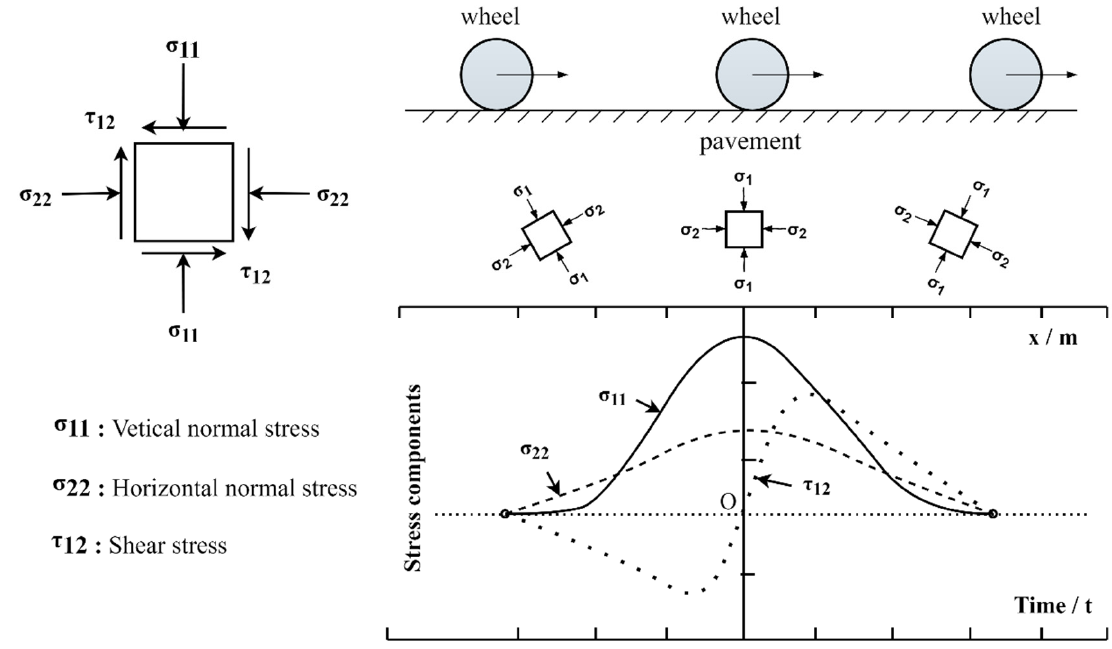
Figure 1. Stress components of soil element in soft subgrade induced by traffic loading.